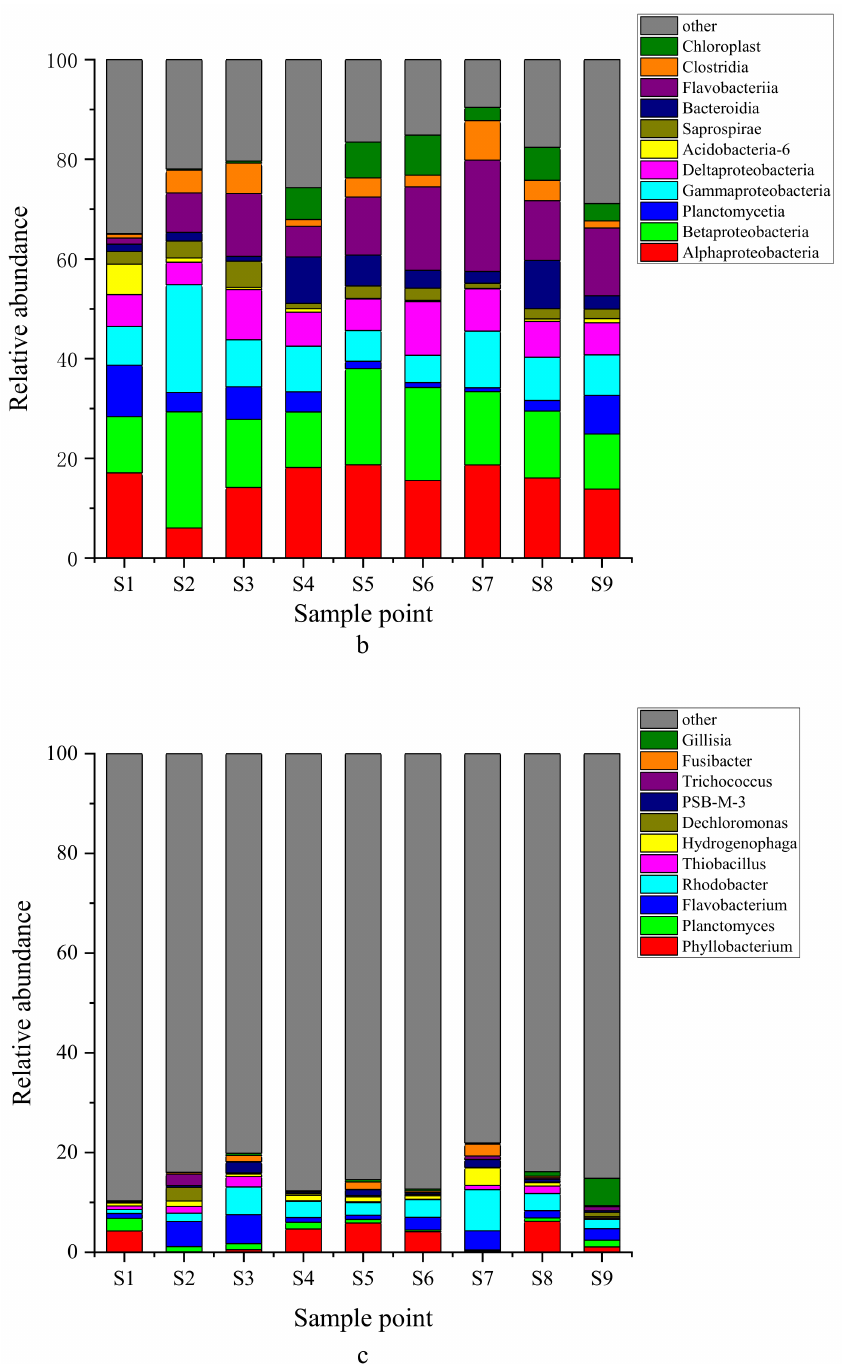
Figure 3. Distribution of bacterial community structure in sediments. (Note: ( a ) relative abundance at the bacterial phylum level in sediments; ( b ) relative abundance at the bacterial class level in sediments ( c ) relative abundance at the bacterial genus level in